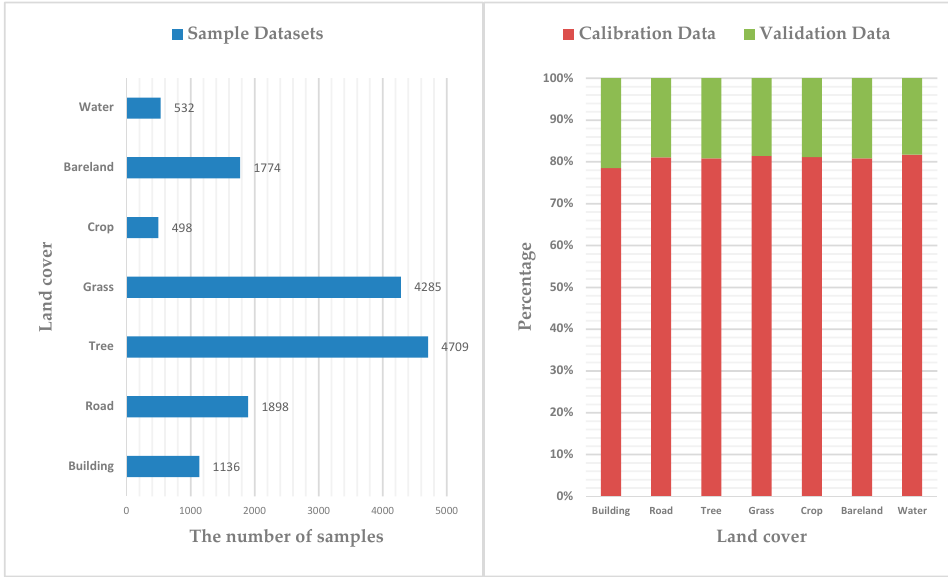
Figure 6. Sample datasets statistics of seven classes ( left ). The proportion of calibration and validation sample data in the sample datasets ( right ).